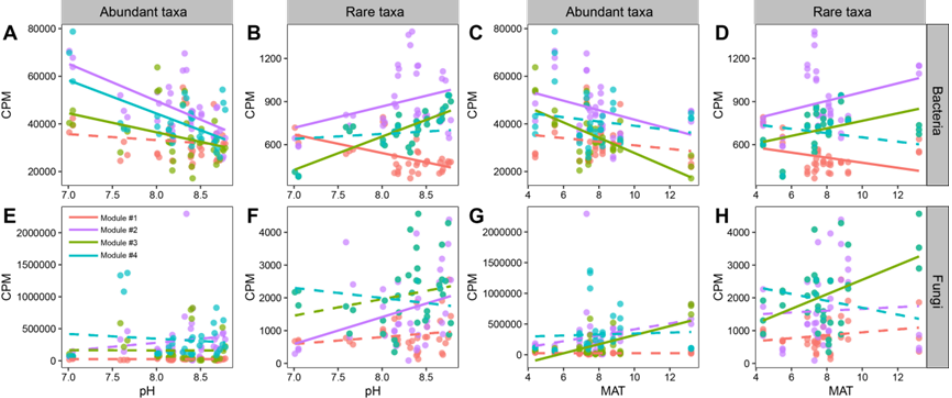
Figure 6. Regression analysis between selected environmental factors (pH and MAT) and accumu- lated relative abundance of rare and abundant bacterial ( A – D ) and fungal ( E – H ) modules in the co-occurrence network. Solid lines indicated significant relationships of p < 0.05; dashed for p > 0.05.